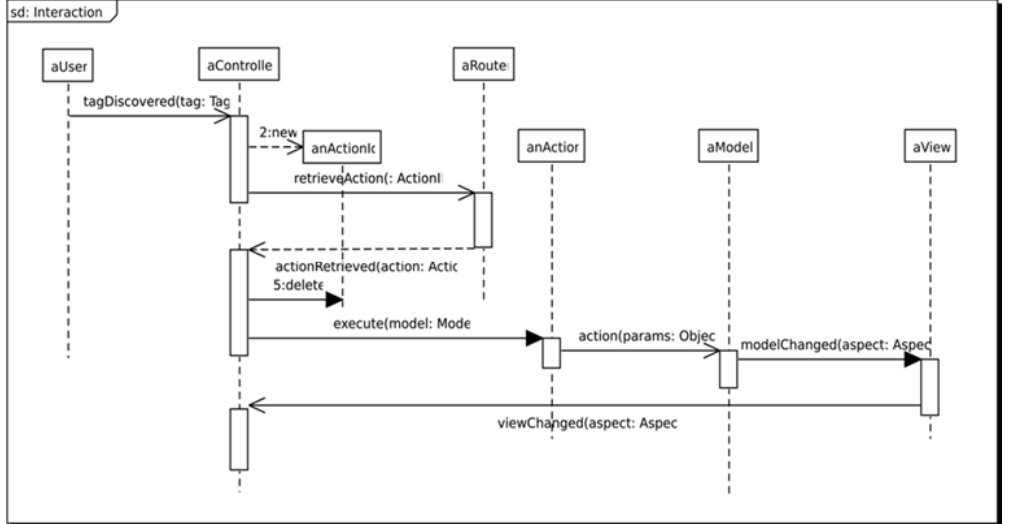
Figure 2. UML sequence diagram that depicts the sequence of interactions among software architecture components when an NFC tag is discovered.